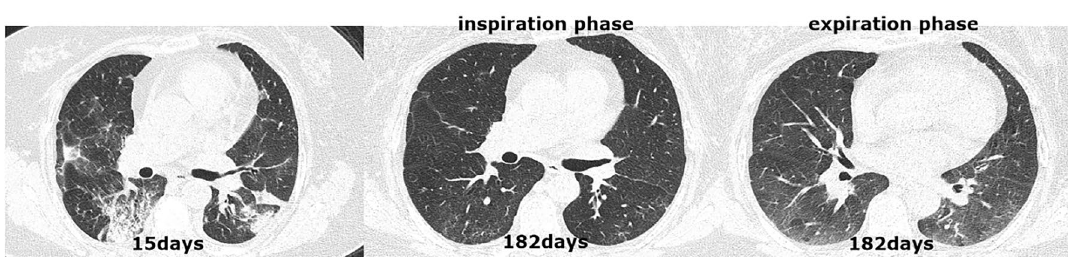
Figure 4. CT scan series in a 37-year-old COVID-19 patient with normal DL CO (107.0%) at the 6-month follow-up. ( a ) Transverse CT scan obtained 15 days after the onset of symptoms showed multifocal ground-glass opacities in the left lung and right lower lobes. ( b , c ) Scans obtained during full inspiration and expiration on day 182 showed that previous opacifications were completely